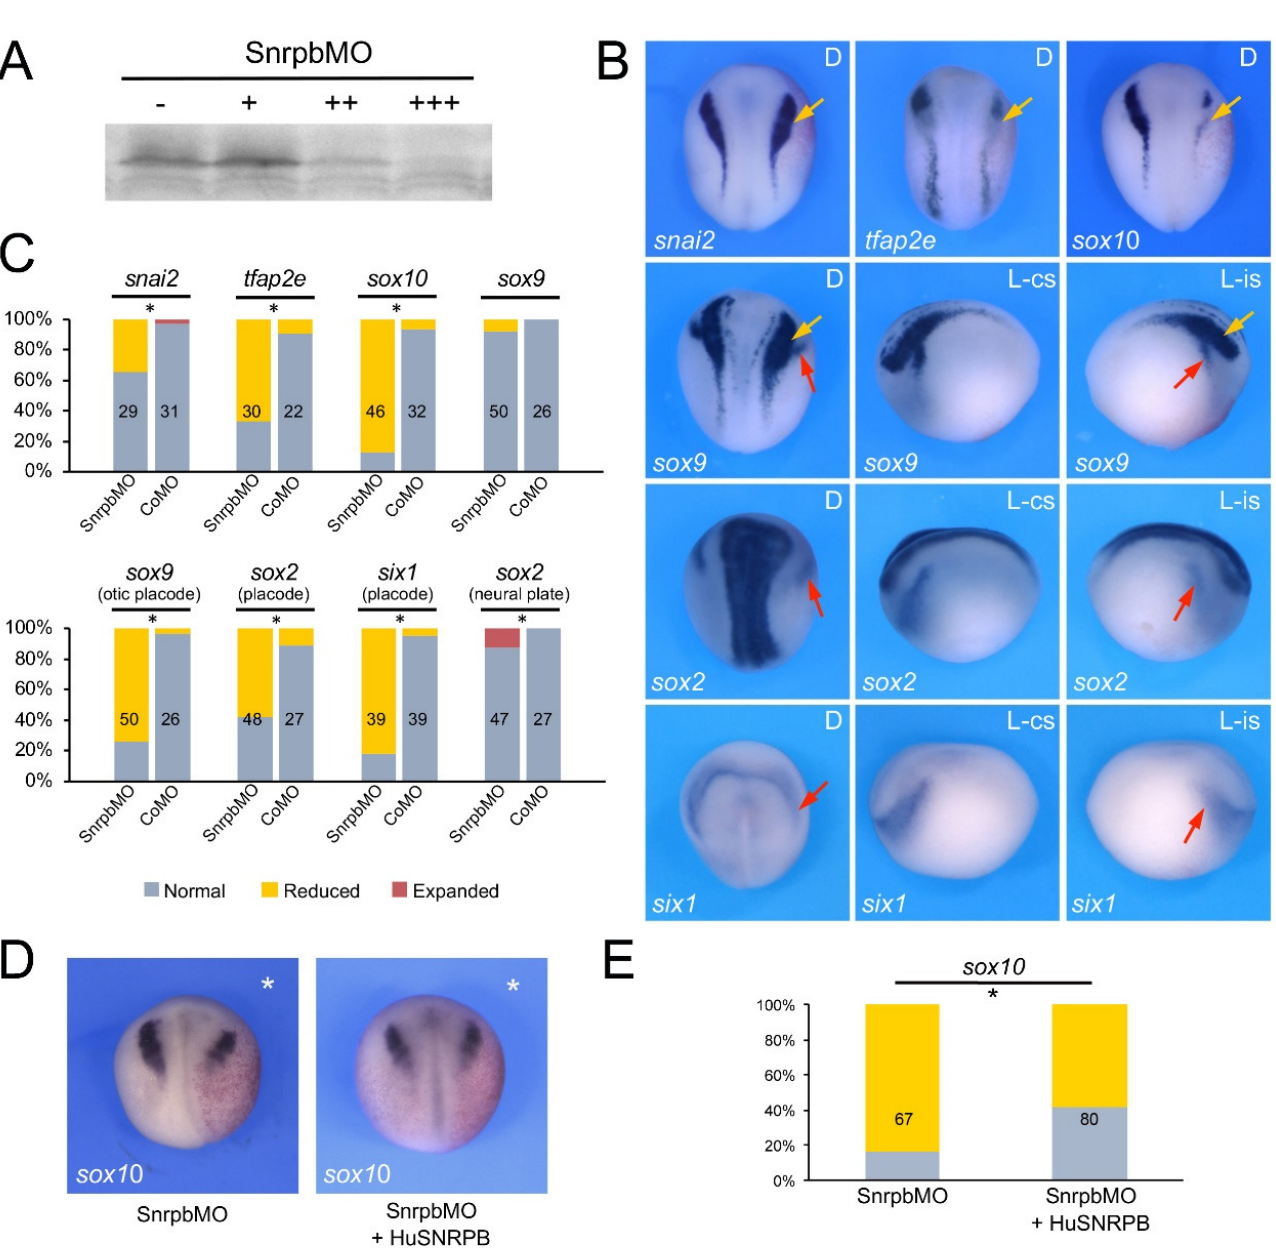
Figure 3. Snrpb knockdown affects neural crest formation. ( A ) Increasing amounts of SnrpbMO, 10 ng (+), 100 ng (++) and 500 ng (+++), block translation directed by snrpb mRNA. (-) Translation without SnrpbMO ( B ) Phenotype of SnrpbMO-injected embryos (5 ng) on neural crest (yellow arrows) and placode (red arrows) gene expression at stage 15. The gene analyzed in each panel is indicated in the lower left corner. D indicates dorsal view, anterior to top. L-cs indicates lateral view control side, anterior to left. L-is indicates lateral view injected side, anterior to right. ( C ) Quantification of the phenotypes. The numbers in each bar indicate the number of embryos analyzed. ( D ) sox10 expression in SnrpbMO-injected embryos is partially restored by expression of HuSNRPB resistant to the MO. The injected side is indicated by an asterisk. Dorsal views, anterior to top. ( E ) Quantification of the results. The numbers in each bar indicate the number of embryos analyzed. Statistically significant differences are indicated (*) p -value < 0.05 (Chi-squared test).